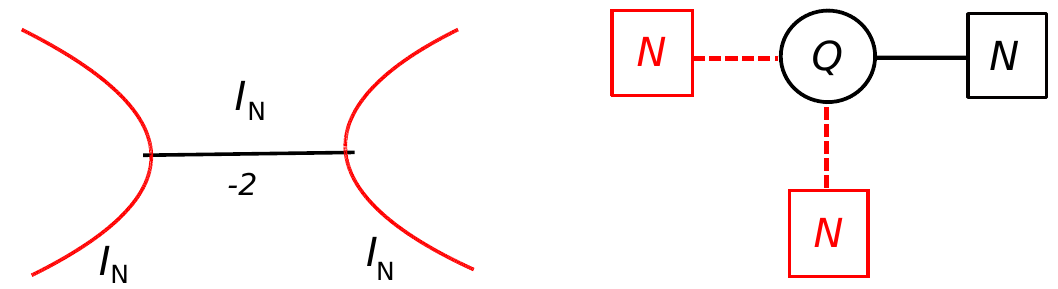
Figure 7. Left: schematic description of the geometry of the F-theory model correspoding to the 2 theory. Right: 2d quiver theory for a bound state of Q BPS strings [64]. SU( N ) symmetry F and contributes an e(cid:11)ective shift to the R -charge by R S 2 on the right hand side of equation (3.9) is a reminder that these surface defects are in- serted at points on the S 2 used for the compacti(cid:12)cation. In the absence of defects, the